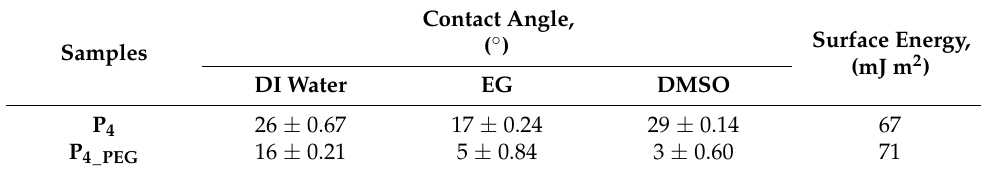
Table 4. Surface energy of TiO 2 film as a function of dispersants added in sol–gel solution.